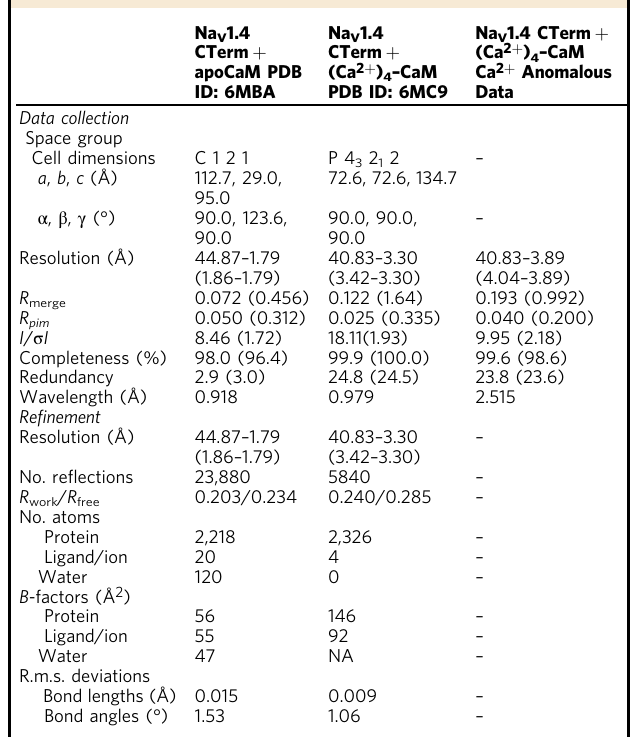
Table 1 Data collection and re fi nement statistics (molecular